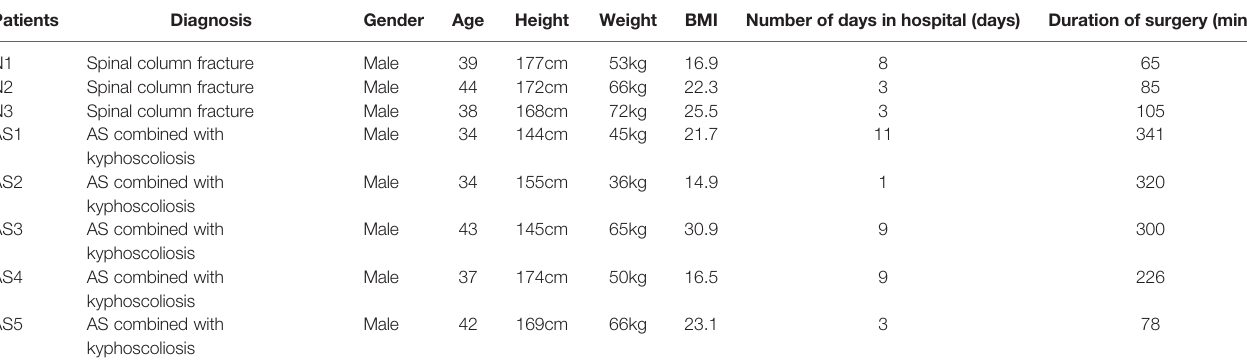
TABLE 4 | Baseline information of the patients used for immunohistochemical analysis.